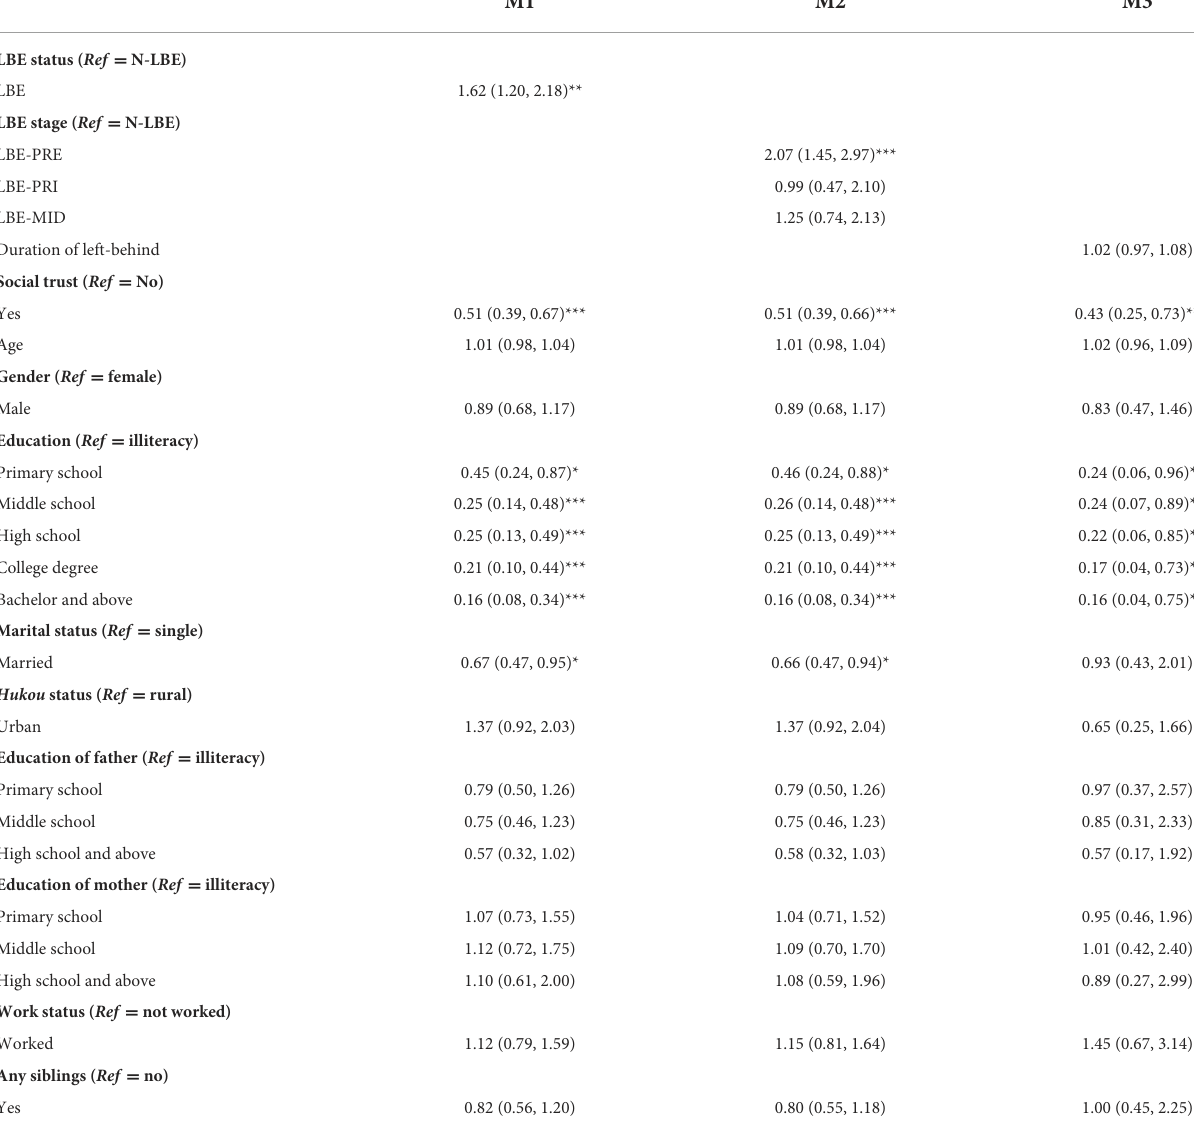
TABLE 4 Logistic analysis for depression, OR (95%